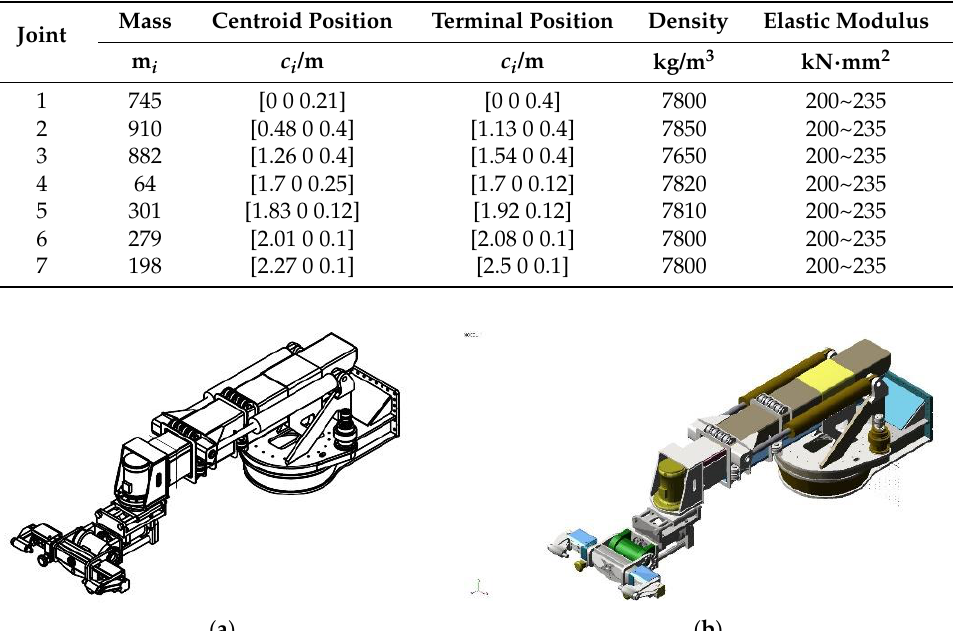
Table 1. Parameters of heavy-duty manipulator.